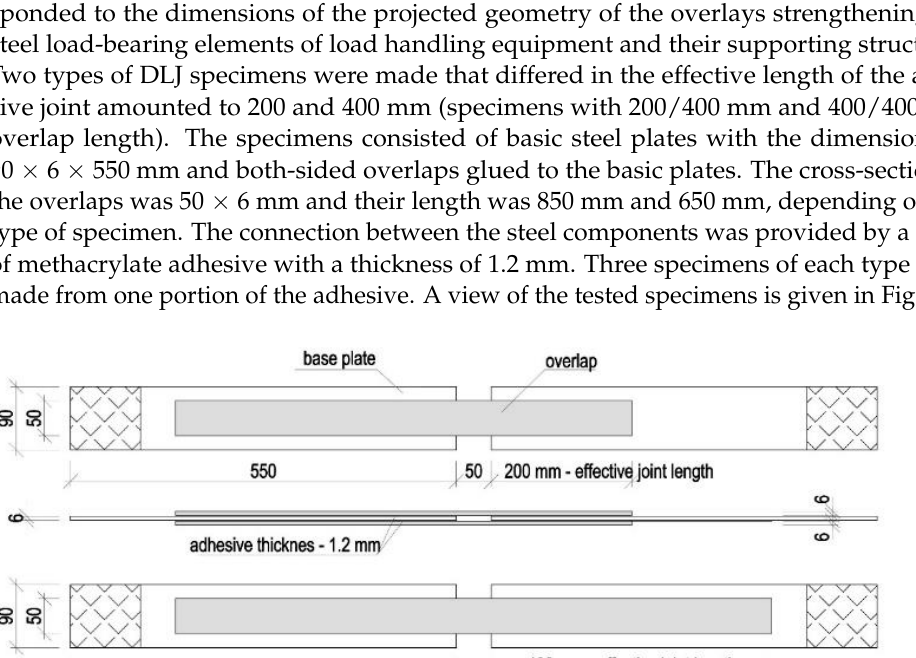
( b ) Figure 8. Specimens prepared for tests with a traditional measurement system (strain gauges): ( a ) model with an effective length of 200 mm; ( b ) model with an effective anchorage length of 400 mm. 3.2. Results and Discussion The detail test results are included in [16]. Only the most important results of the basic model tests performed are discussed here. It should be explained that in the full laboratory tests four specimens of each type were made, while the fourth model in a given series was made later with the use of glue from another portion. These additional specimens were used to perform optical measure- ment of deformation using the Digital Image Correlation method (DIC). Due to the fact that slightly different characteristics were obtained (which was explained by slightly dif- ferent parameters of the glue, as in [16]), the results of additional models were omitted in this paper because the material tests were performed for the portion of glue used to make the basic specimens (three of each type). The behavior of the tested specimens is illustrated by the relationship between the tensile force and elongation of the tested elements, as shown in the Figure 9a,b.